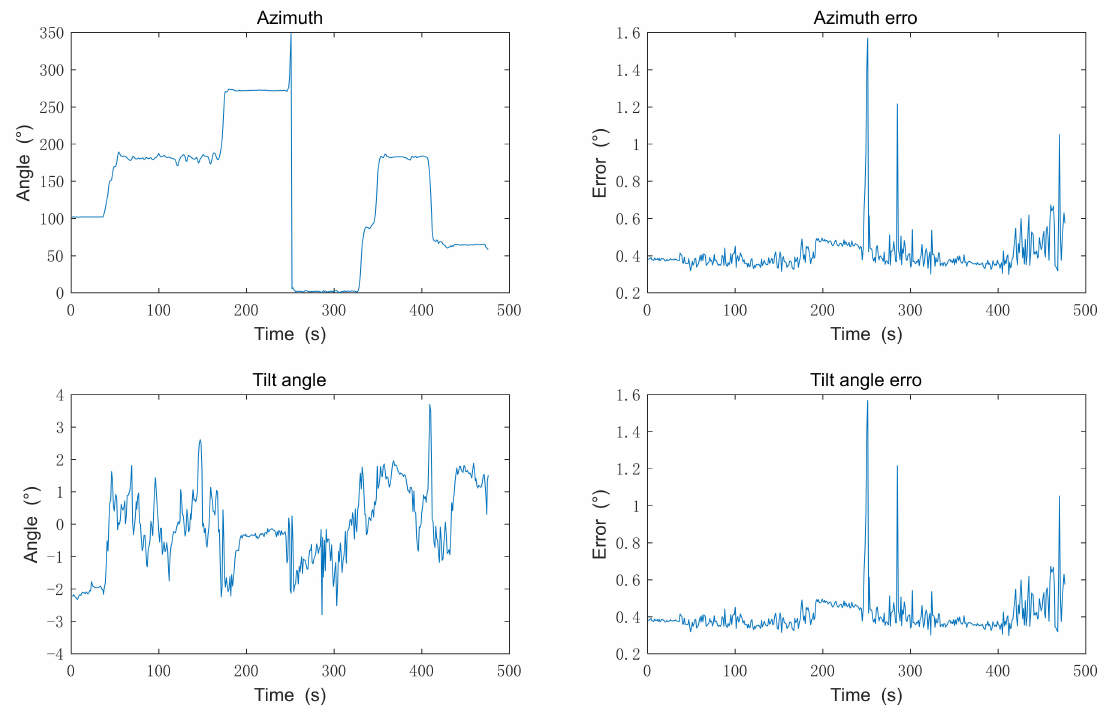
Figure 10. Angles and